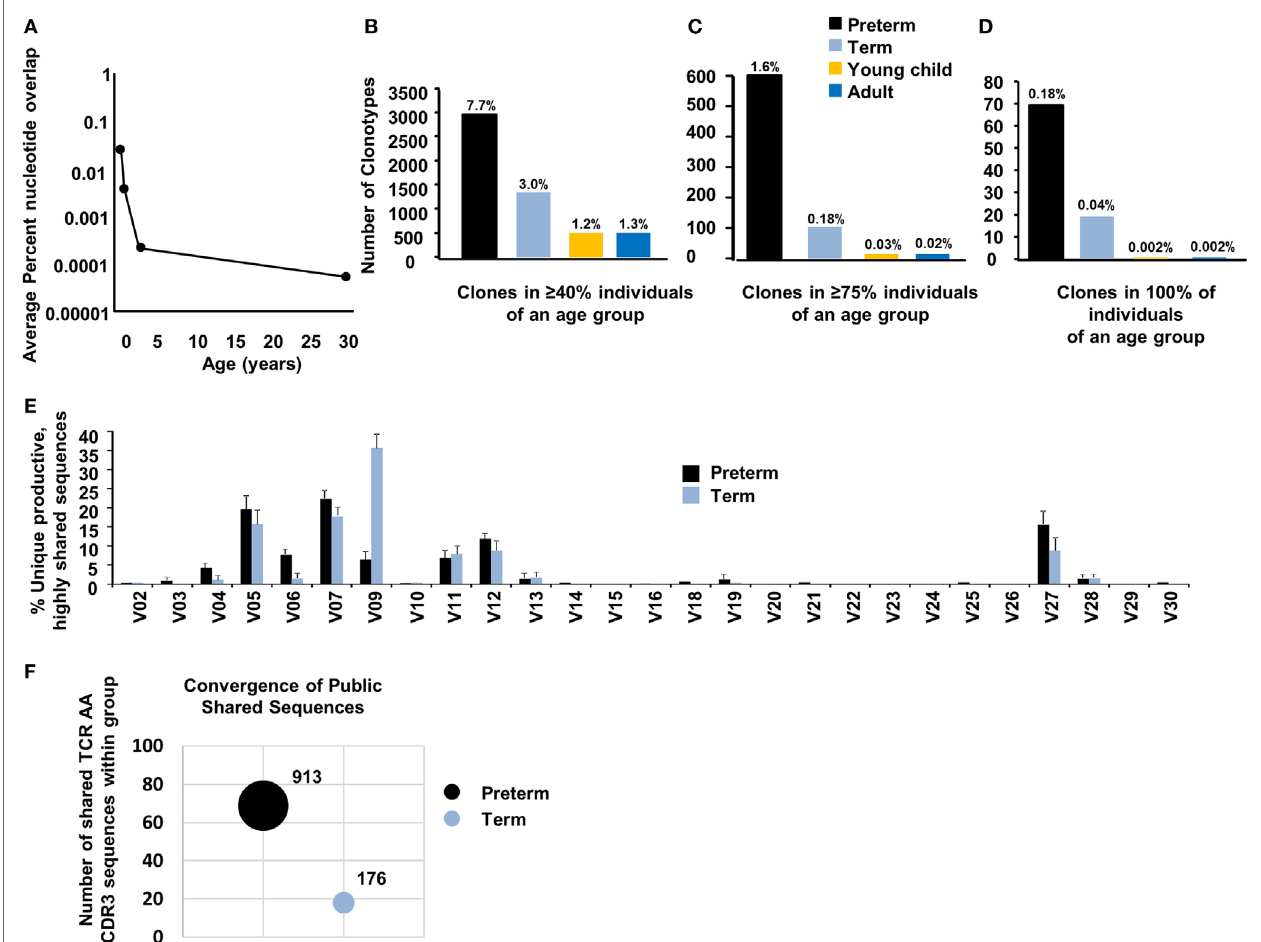
FigUre 4 | Public clones are enriched in the preterm TCR repertoire. (a) Average percent nucleotide overlap within each age group. The number of clonotypes which are shared with (B) at least 40%, (c) at least 75%, and (D) 100% of the individuals within that particular age group is depicted. (e) The percentage of V β gene family usage (mean ± SEM) for the highly public (shared in greater than or equal to four of the individuals) unique productive sequences within each preterm and term neonate is shown. (F) Bubble plot comparing TCR convergence between preterm and term neonate highly shared TCR present in all individuals. Bubble size relative to the number of single TCR nucleotide sequences contributing to shared complementarity-determining region 3 (CDR3)